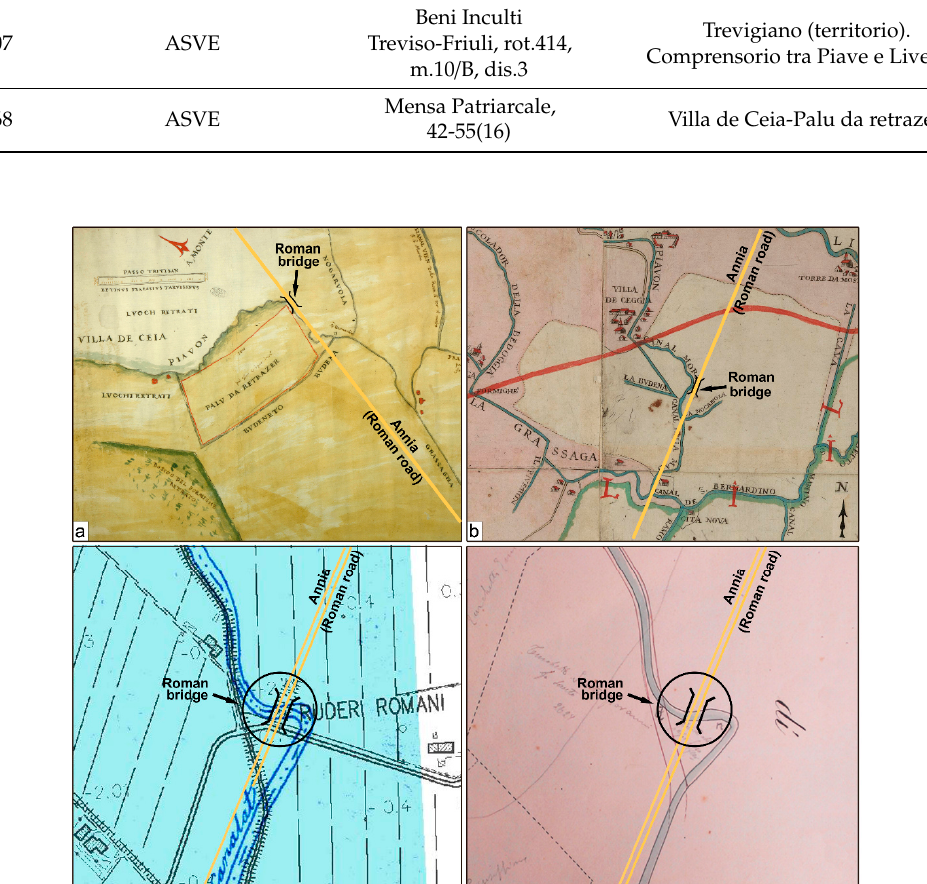
Figure 5. Historical maps of the study area (in orange), and details of the route of the Via Annia (in yellow) and the Roman bridge (in black). ( a ) Drawing (1568) showing the sector to be reclaimed, i.e., the “retrazer palv”, south of the Piavon canal (today’s Canalat)-Archivio di Stato di Venezia, MP 42-55 (16); ( b ) Map (1639) depicting the marshes (in light yellow), ploughed and inhabited land (in pink), watercourses (in blue)-Archivio di Stato di Venezia, SEA, Piave, r.106, dis.15; ( c ) Detail of the map (1840) of the Santini Cadastre (in blue), superimposed on the CTR 1:10,000 (in black), which shows the relationship of the Canalat with the Annia Roman bridge; ( d ) Detail of a 1914 map showing the rectification of the Canalat bend in relation to the Roman bridge-Consorzio di Bonifica Veneto Orientale. The route of the Via Annia , the Canalat course and the location of the Roman bridge allow to identify the study area in the